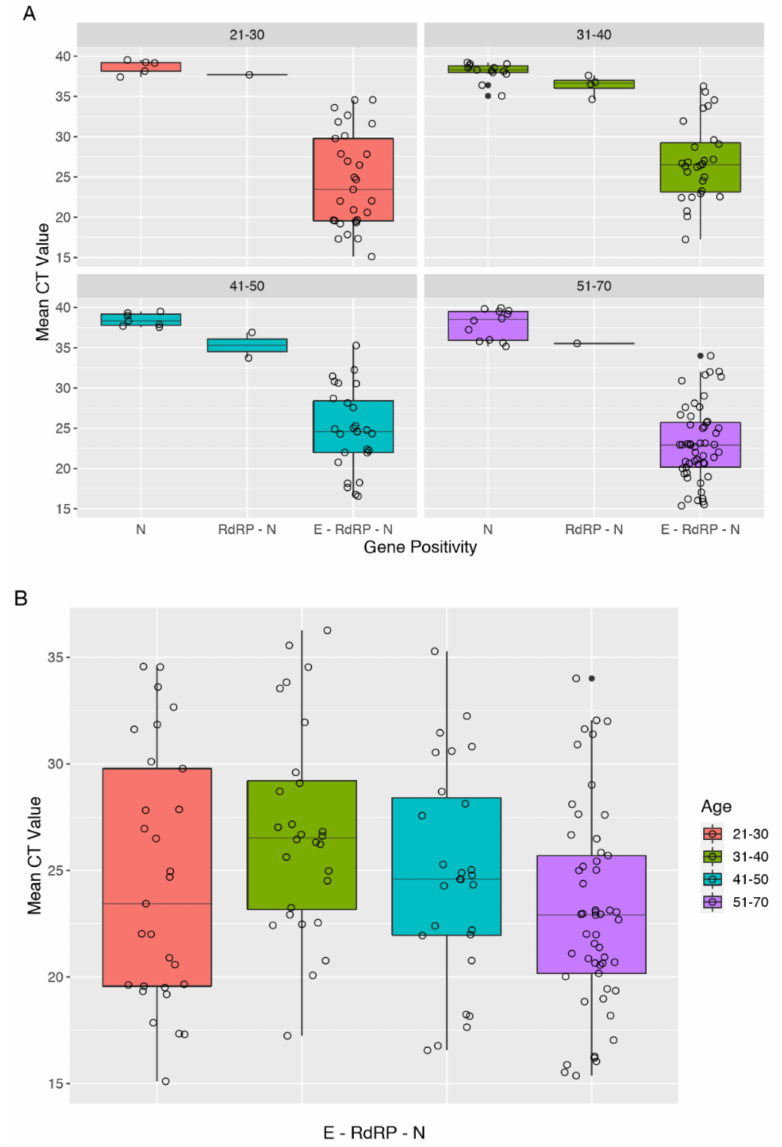
Figure 3. Distribution of gene positivity and mean cycle threshold (CT) values among di ff erent age groups. ( A ) Box-plot of mean viral load (cycle threshold) across di ff erent ages according to gene positivity. Empty circles represent a single observation for each gene. ( B ) Box-plot of mean viral load at baseline for the gene positivity E–RdRP–N among di ff erent age-groups. Empty circles represent a single observation for each age